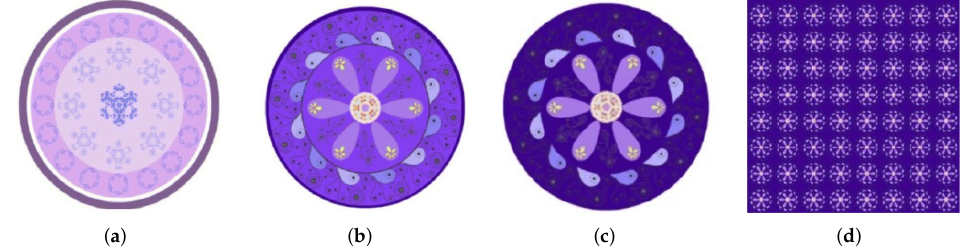
Figure 27. Basic patterns and filling the fabric using these patterns (Wang et al. [56]). ( a ) L-system based, ( b ) Julia set based, ( c ) basic pattern, and ( d ) pattern on Fabric.